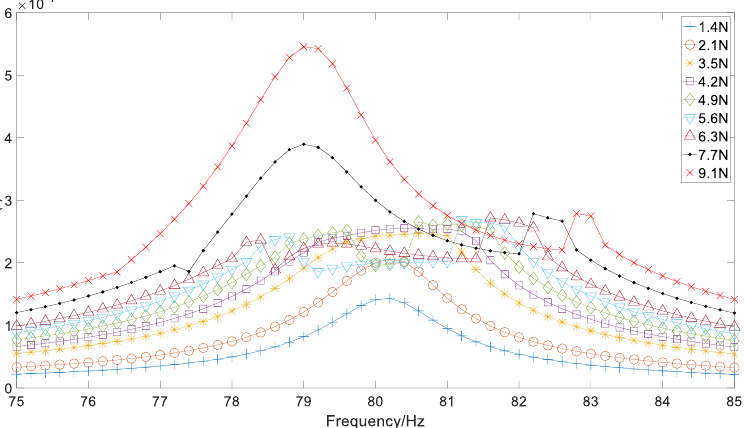
Figure 5. The numerical responses of the acoustic displacement u ( t ) under the excitation amplitude range [1.4 N, 9.1 N] and the frequency range [75 Hz, 85 Hz].